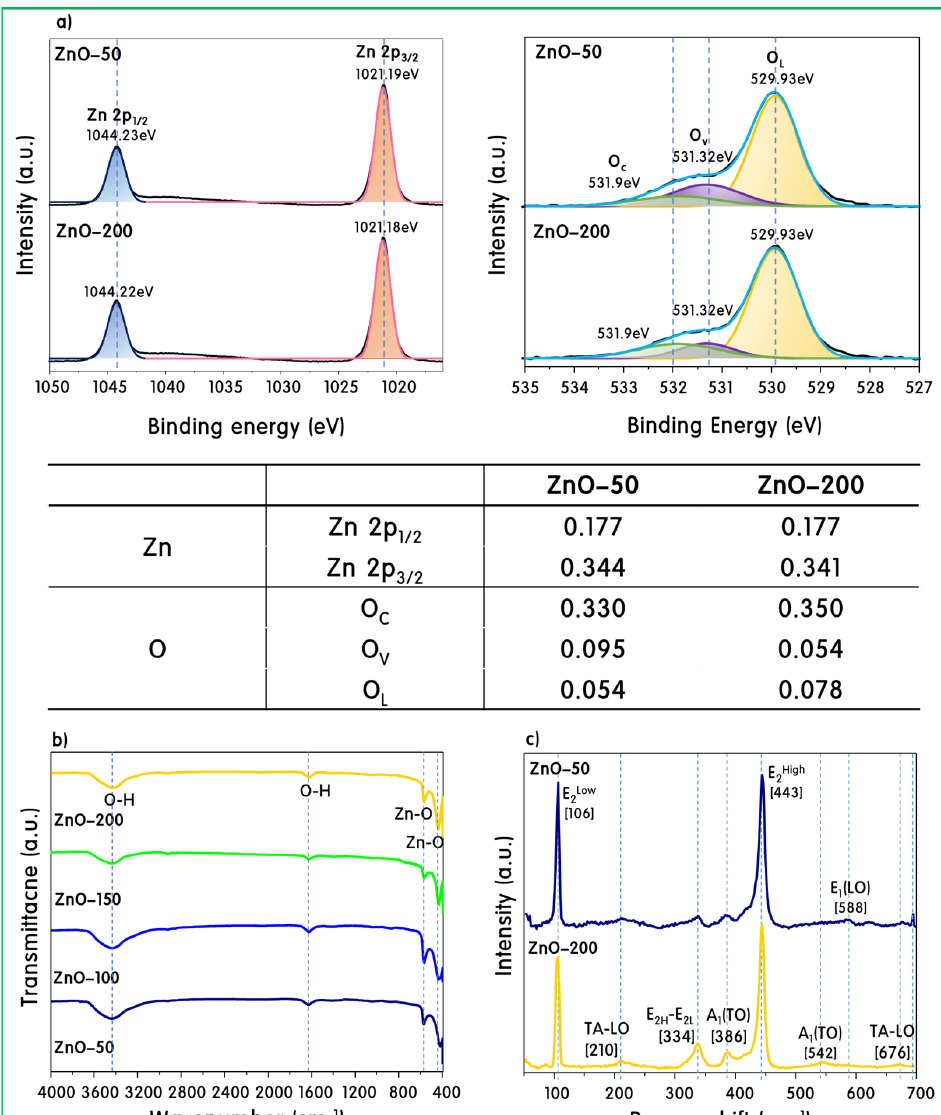
Figure 3. ( a ) XPS spectra, ( b ) FTIR spectra, ( c ) Raman spectra of ZnO nanoplates.